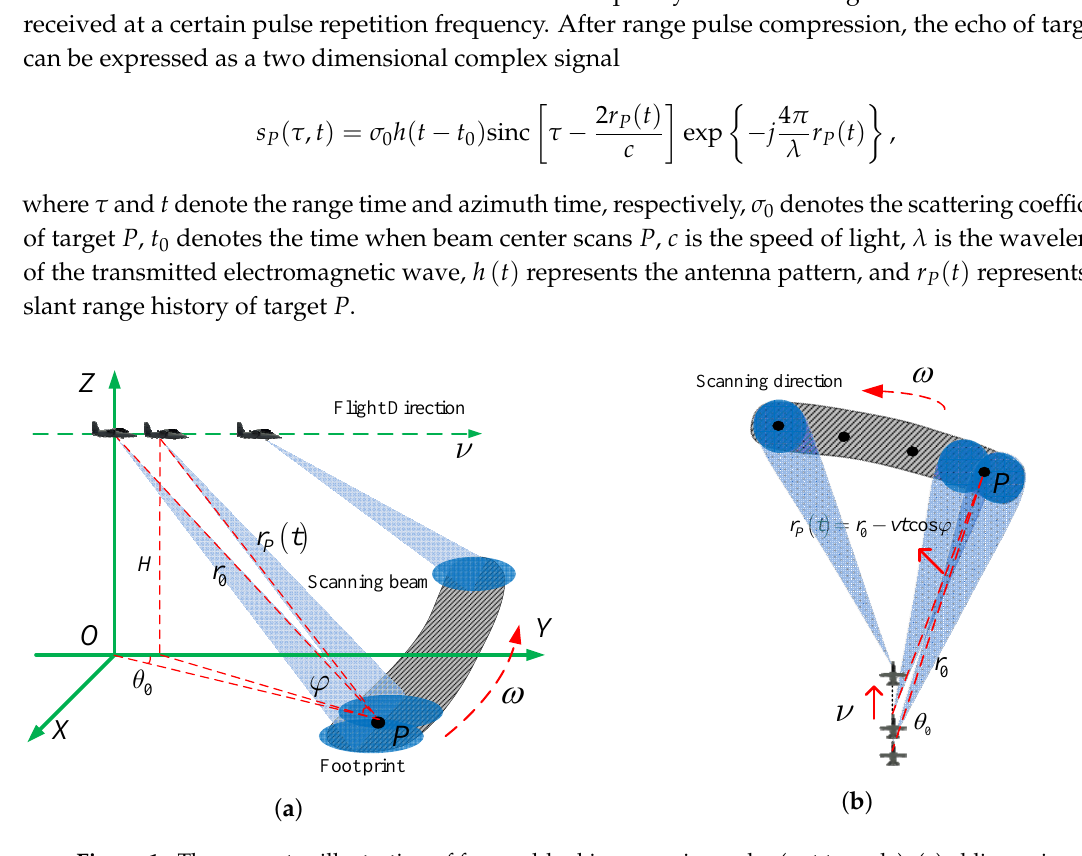
Figure 1. The geometry illustration of forward-looking scanning radar (not to scale). ( a ) oblique view ( b ) top